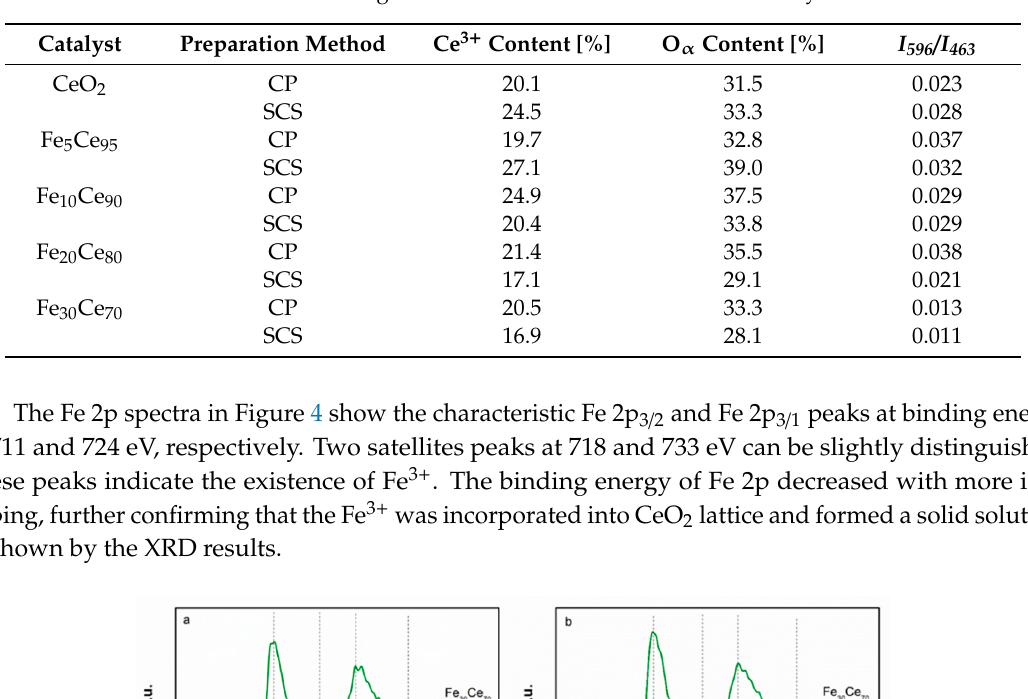
Figure 3. XPS spectra of Ce3d: ( a ) Co-precipitation method, ( b ) solution combustion synthesis method. Table 2. Curve fitting results of Ce3d and O1s on obtained catalysts.